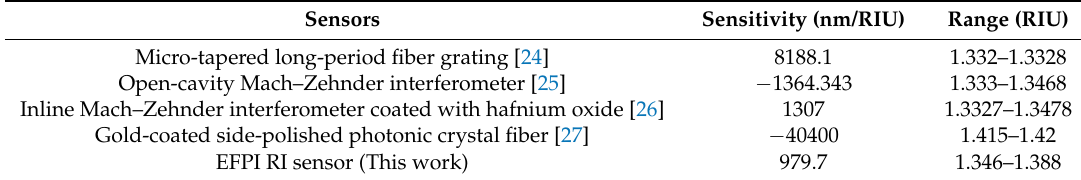
Table 1. Sensitivities and ranges of different sensor constructions.